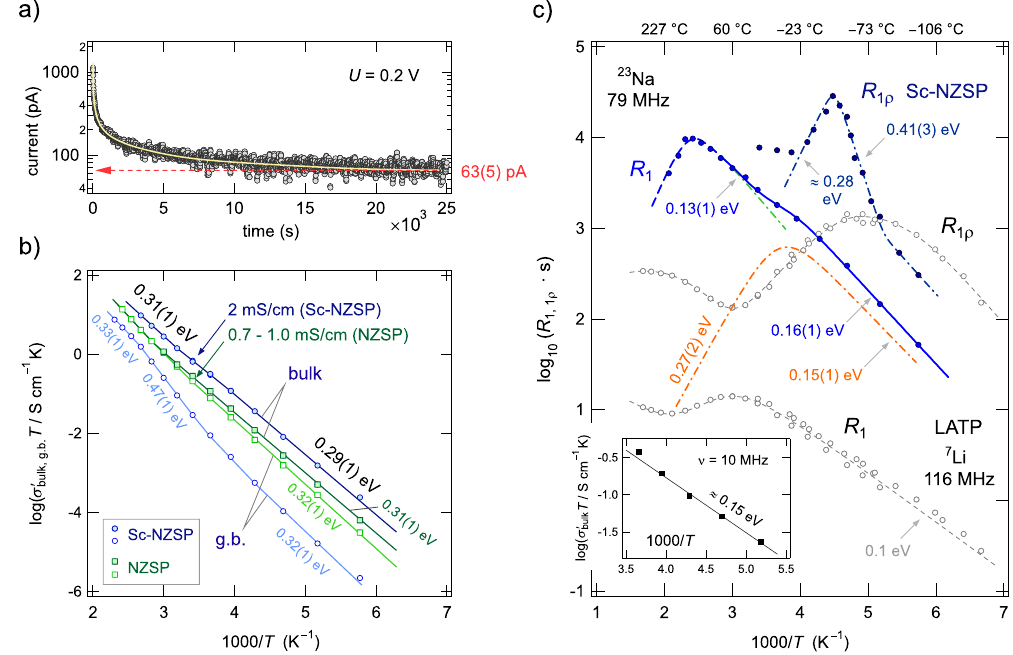
Figure 2. Electronic conductivity and temperature dependence of σ ′ of Sc-NZSP, 23 Na NMR spin-lattice relaxation. ( a ) Constant voltage (direct current) polarization curve of a sintered Sc-NZSP pellet. The high ionic conductivity translates into a rapid decay of the current at the beginning of the experiment. After a time lapse of sufficient length, the current approaches a value that is solely due to the transport of electrons. ( b ) Temperature dependence of the bulk and g.b. conductivity of Sc-NZSP ( σ bulk (298 K) = 2.0 mS cm − 1 ). The results for NZSP free of Sc are also shown ( σ′ bulk (298 K) = 1.0 mS cm − 1 ; σ ′ g.b. (298 K) = 0.7 mS cm − 1 ). Filled symbols refer to bulk values, open ones represent the g.b. response. Crosses show conductivities taken from ref. 22 . ( c ) 23 Na spin-lattice relaxation rates ( R 1 , R 1 ρ ) of Sc-NZSP recorded in both the laboratory frame of reference (79 MHz, R 1 ) and the rotating-frame of reference (20 kHz, R 1 ρ ). The sharp diffusion-induced peak of the latter and the shoulder of the R 1 (1/ T ) curve indicate extremely rapid Na ion diffusivity with rates in the order of ω 0 /2 π ≈ 5 × 10 8 s − 1 at T as low as 260 K. Error bars of the data points are smaller than the size of the symbols used. The solid line shows a fit with two BPP-terms to approximate the R 1 rates; the dashed-dotted line highlights the asymmetric low- T peak with the activation energies 0.15 eV and 0.27 eV, respectively. The dashed-dotted line drawn through the R 1 ρ data points is to guide the eye. Unfilled symbols represent, for comparison, results from analogous measurements on a Li-analogue compound,